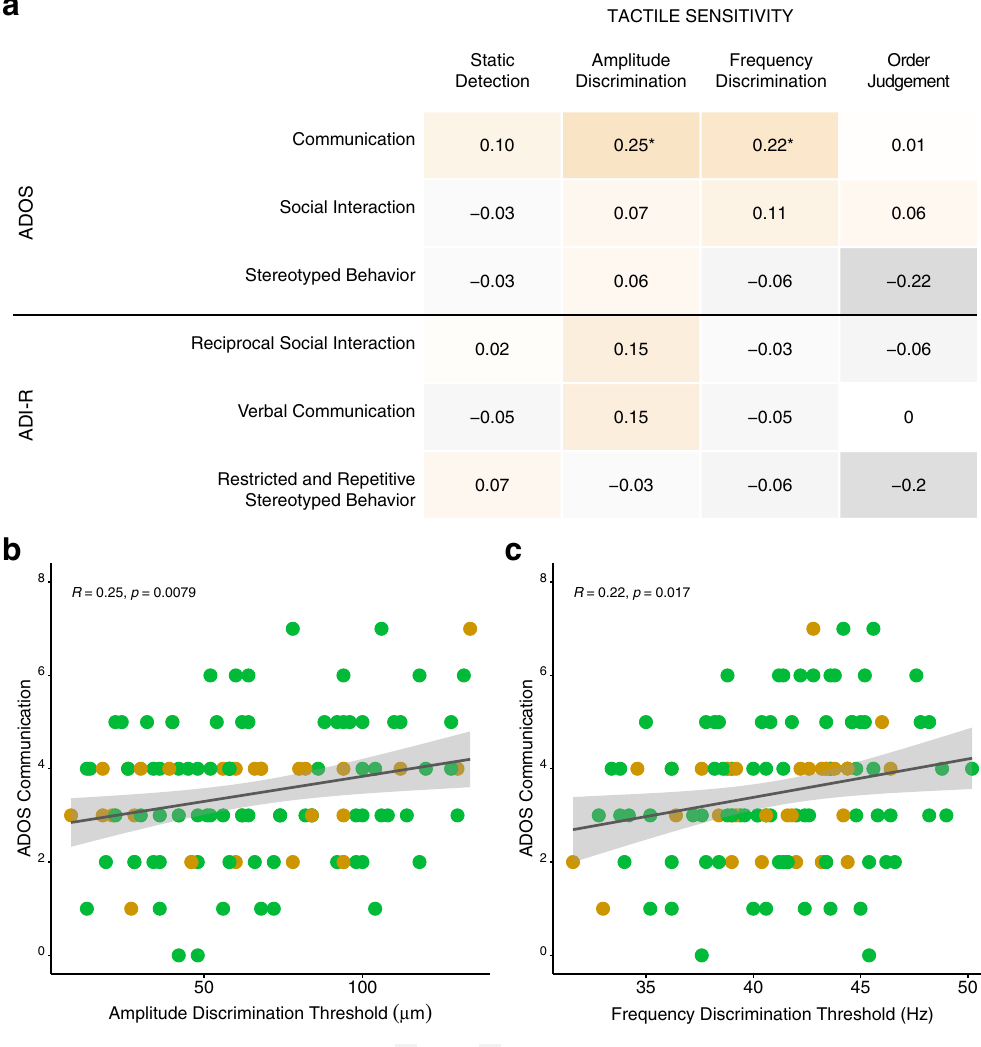
Fig. 7 Correlation analyses between tactile sensitivity thresholds and total domain scores from the Autism Diagnostic Observation Schedule and Autism Diagnostic Interview-Revised. a Heatmap correlations between subscales of the Autism Diagnostic Observation Scale and Autism Diagnostic Interview-Revised ( y -axis) and relevant tactile sensitivity metrics ( x -axis). The “ * ” are used to denote statistical signi fi cance after correcting for multiple correlations using Bonferroni ’ s correction (* p < 0.05, ** p < 0.01, *** p < 0.001). Due to the large number of correlations being conducted, Bonferroni corrections were applied to each of the correlation analyses conducted by multiplying the resulting p -value of each correlation between a given tactile sensitivity metric by the number of subscale items within each questionnaire. Two associations survived Bonferroni corrections and are presented in the bottom row of the fi gure. There were positive correlations between problems with communication on the Autism Diagnostic Observation Scale with ( b ) amplitude discrimination thresholds and ( c ) frequency discrimination thresholds. See Supplementary Results, Supplementary Fig. 8 for additional correlation analyses. Note that the p -values (* p < 0.05, ** p < 0.01, *** p < 0.001) presented within each scatterplot are the unadjusted p -values. ASD autism spectrum disorders, ADHD attention-de fi cit hyperactivity disorder, ADOS Autism Diagnostic Observation Scale, ADI-R Autism Diagnostic Interview-